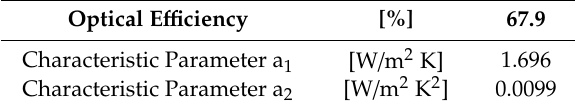
Table 1. Performance curve data of a vacuum tube collector Sunwood SW15 / 20